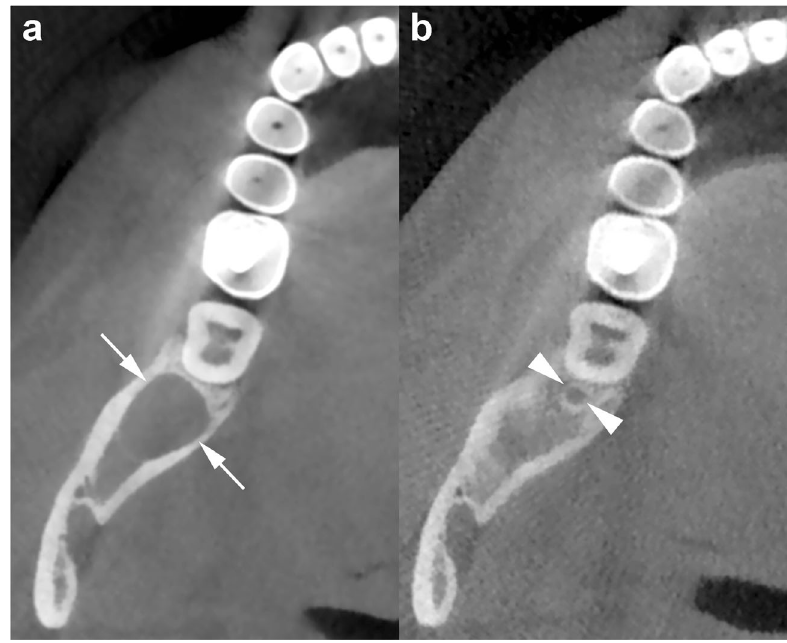
Fig. 18 Periodic follow-up of the same patient in Fig. 16 with NBCCS. a Axial CBCT image shows a new lesion in the third molarregionoftherightmandible ( arrows ), which was subsequently surgically treated. b